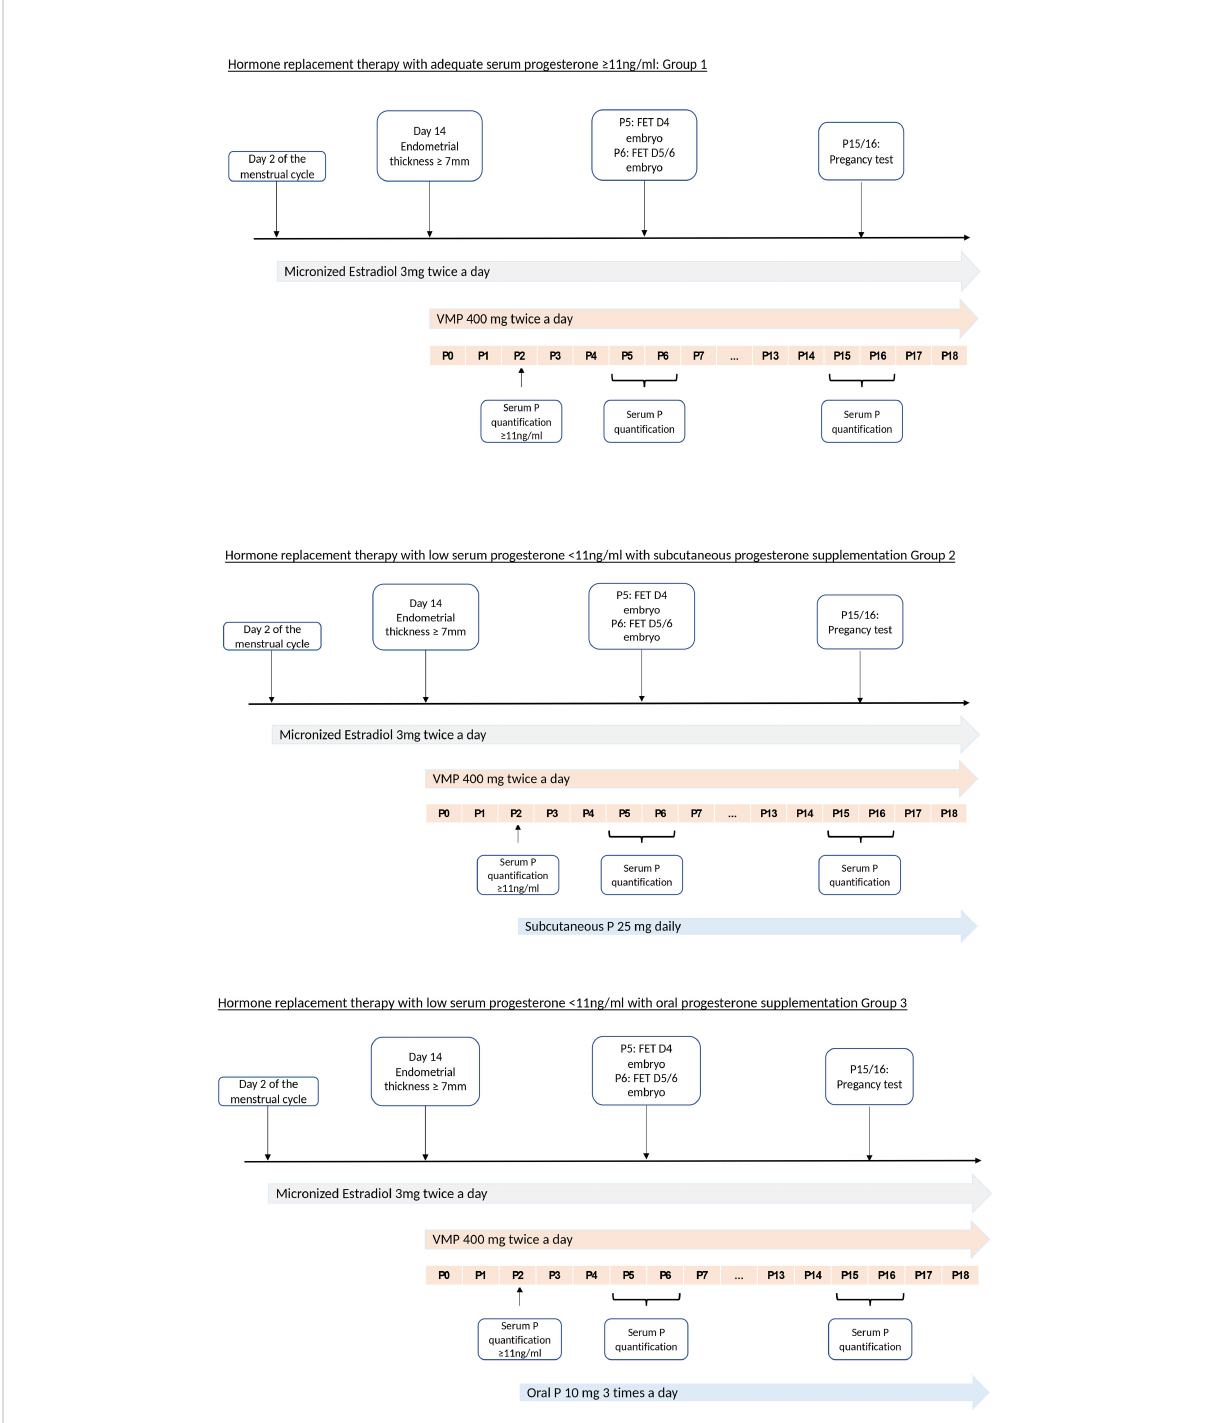
FIGURE 1 Hormone replacement therapy in each group according to the serum progesterone concentration P, progesterone; MVP, Micronized Vaginal Progesterone; P0, 1 st day of progesterone supplementation starting on the evening FET, frozen embryo